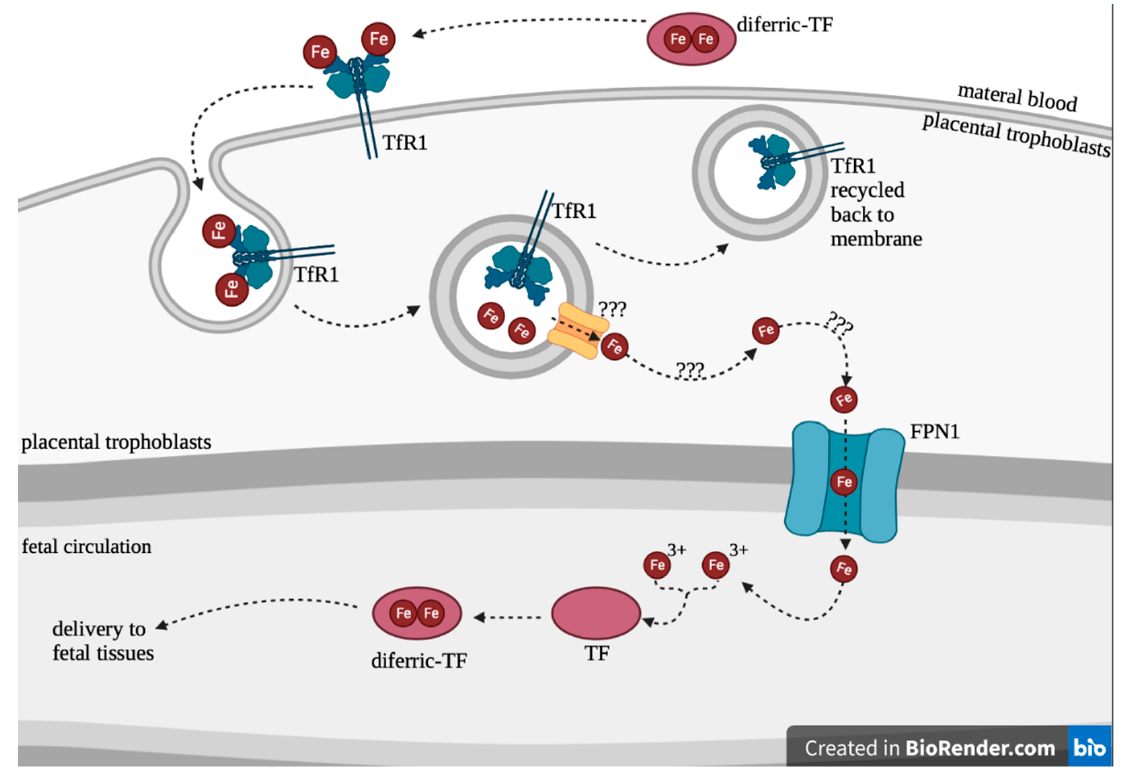
Figure 1. Placental iron transportation.